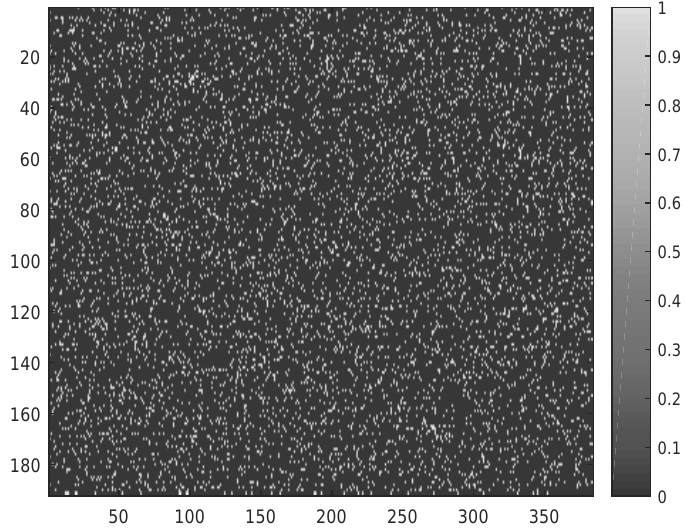
Figure 2. Example of sparse binary sensing matrix sized 192 × 384, corresponding to a 50% compression rate. Black elements are zero, white elements are